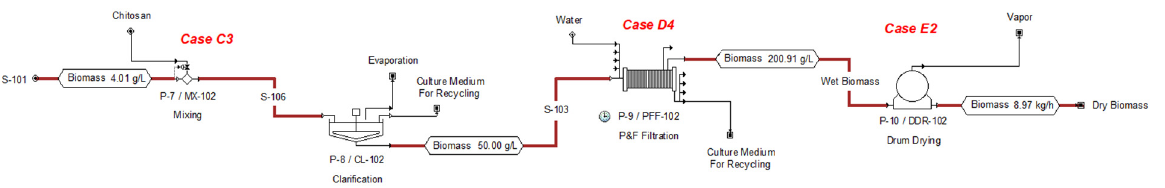
Figure 5. Flowsheet for the harvesting section (primary and secondary) and drying stage, of scenario 24 (case C, D and E).